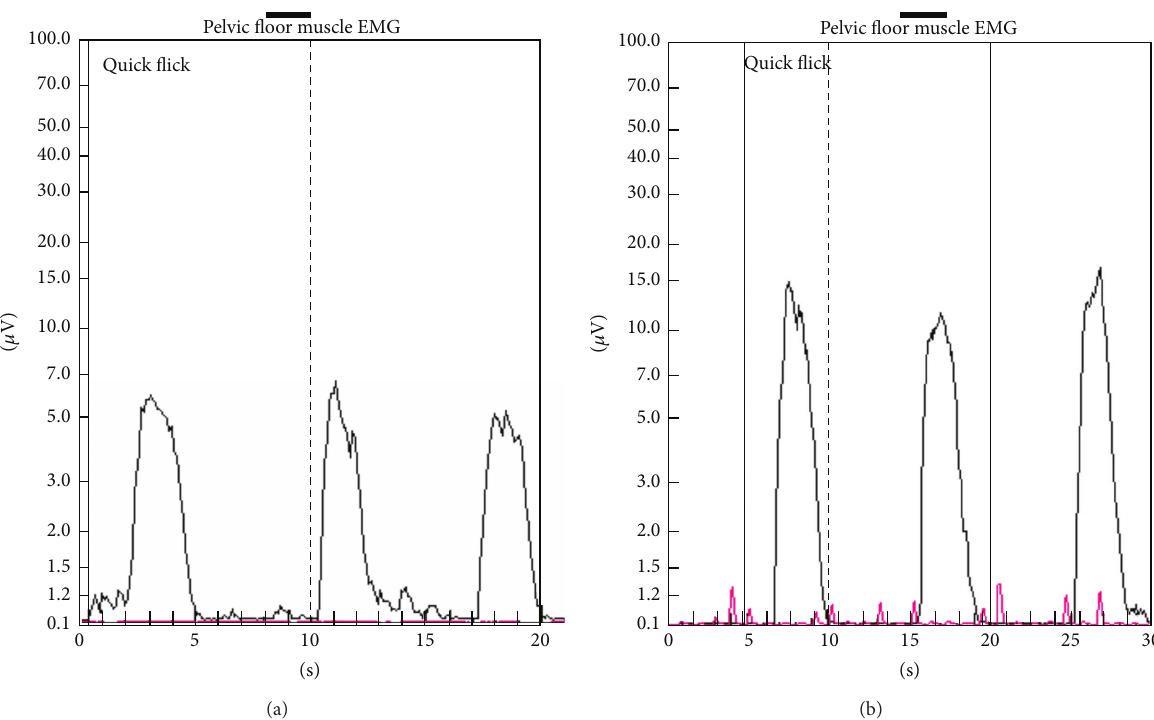
Figure 3: Pelvic floor muscle strengthening. (a) Electromyographic tracing of a patient with stress urinary incontinence during a series of rapid contractions (“quick flicks”) in which the patient is asked to contract and relax over multiple 5-second intervals. The tracing reveals reduced electrical activity and recruitment during contractions (5mcV) on the initial session. (b) Same patient following sessions of pelvic muscle rehabilitation revealing marked increased electromyographic activity during the contraction (15mcV) phase of the rapid contraction (“quick flicks”).